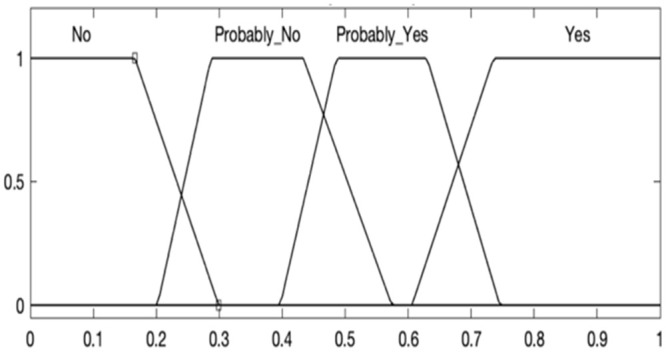
Fuzzy System sets.